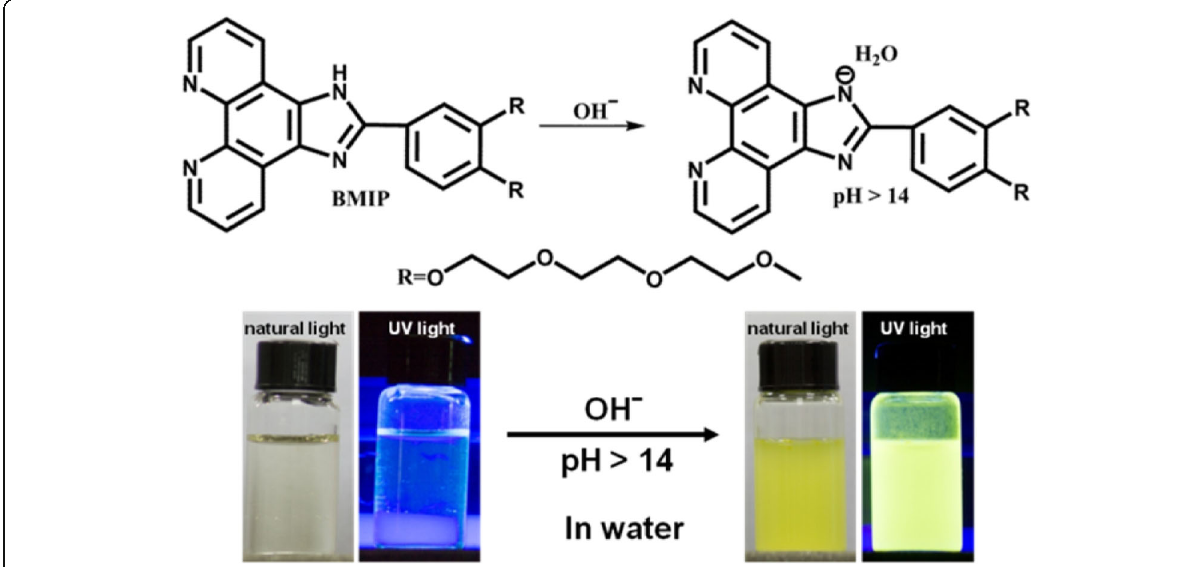
Fig. 1 The detection mechanism for extreme alkalinity (pH > 14); photos shot under natural light (left) and UV light (365 nm)